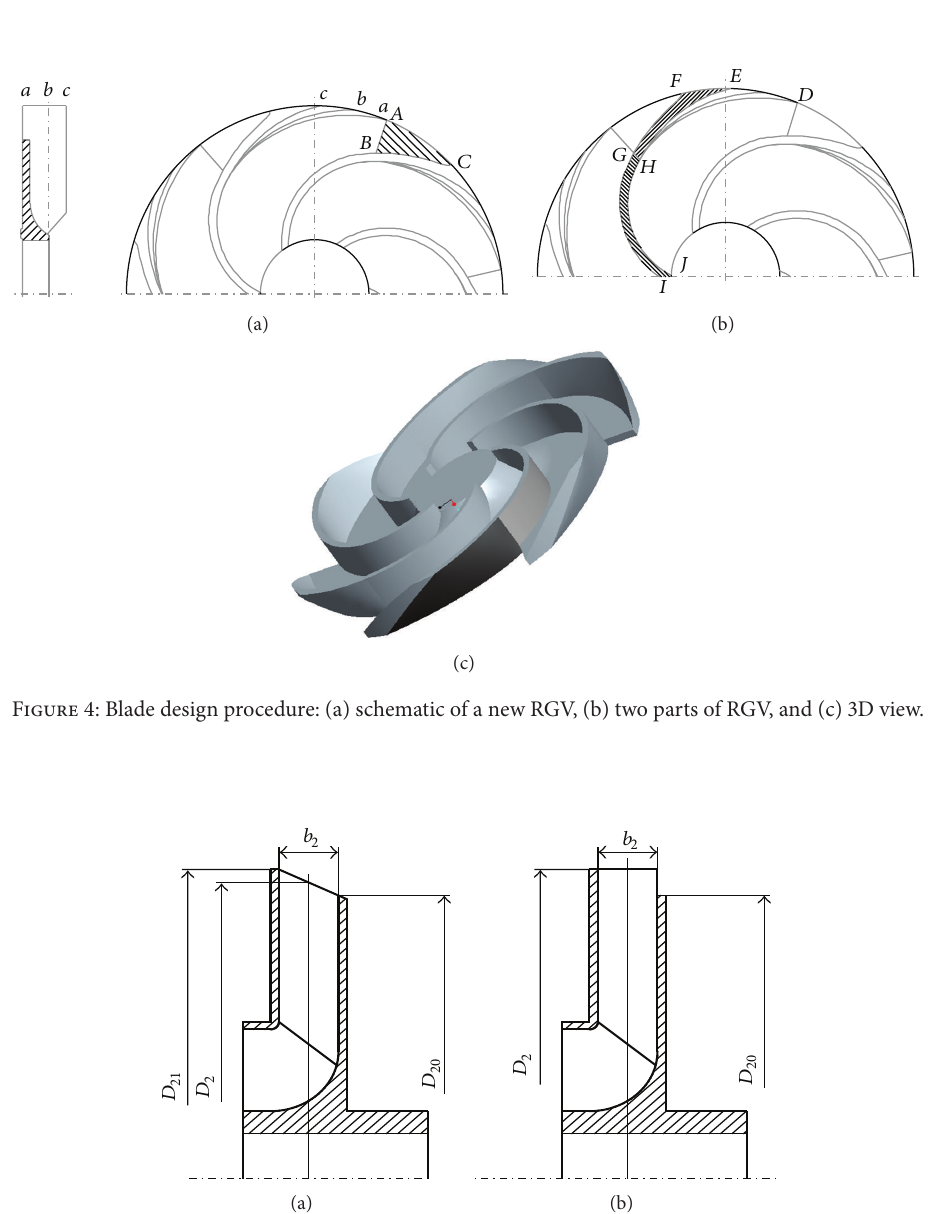
Figure 3: A multistage pump with compact stages: (a) assembly and (b) RGV.